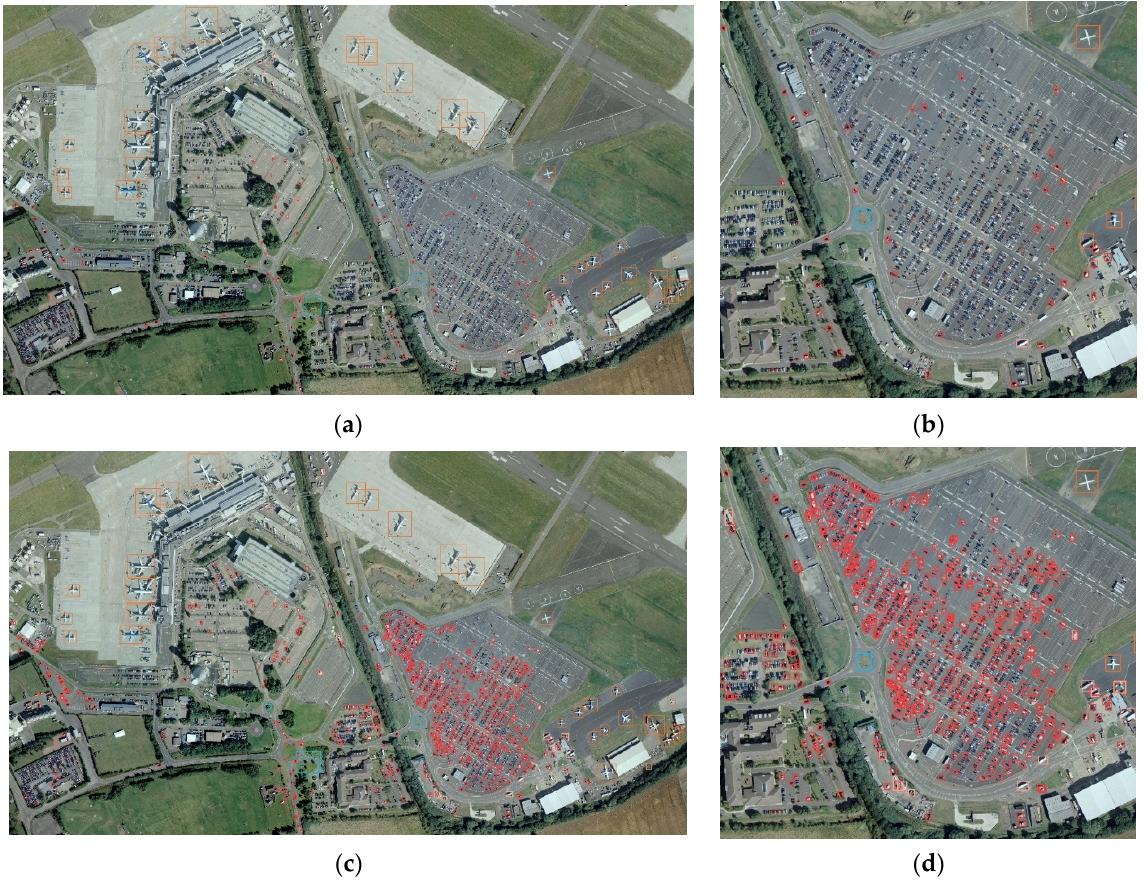
Figure 9. The detection examples: ( a ) Detection result of an example from DOTA validation set using YOLOv5l; ( b ) Detail view of ( a ); ( c ) Detection of the same picture; ( d ) Detail view of ( c ).